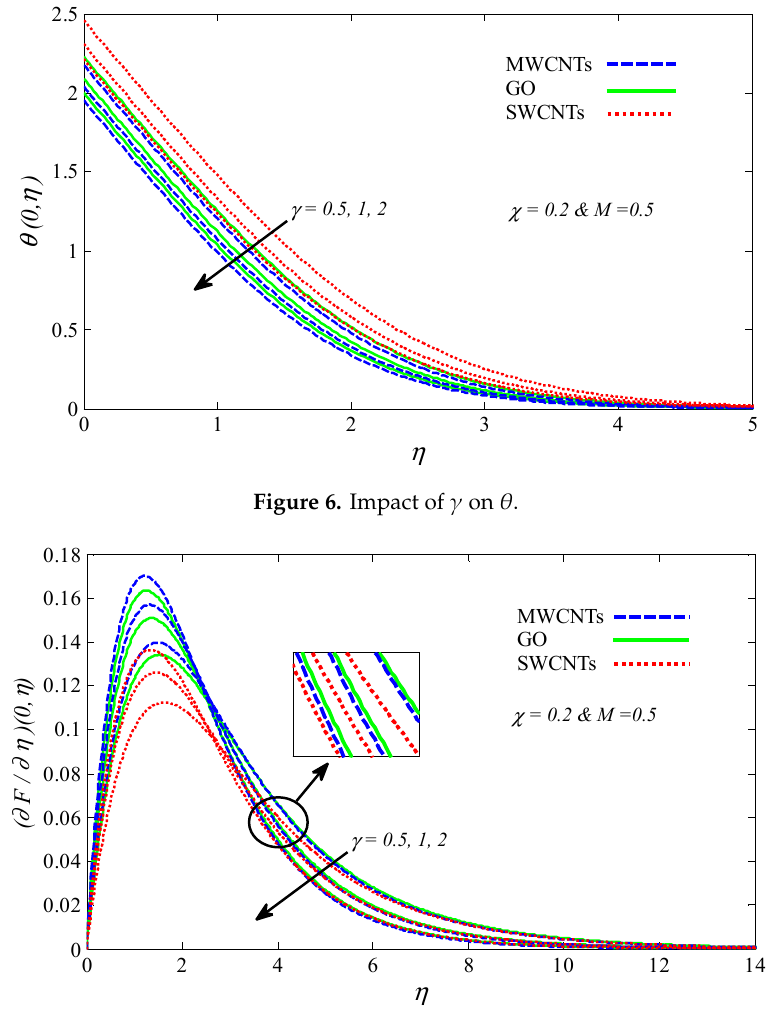
Figure 7. Impact of γ on ∂ F / ∂η